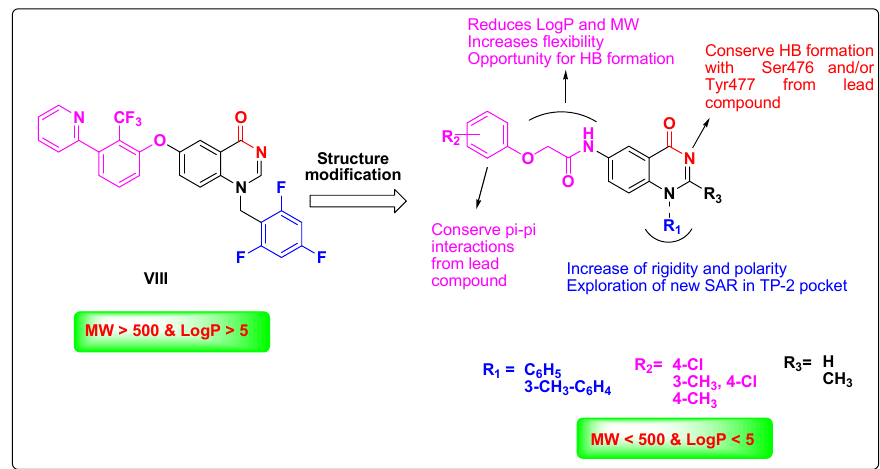
Figure 2. Rationale of the designed target compounds to act as NS5B inhibitors that fulfil Lipinski’s rule of five.